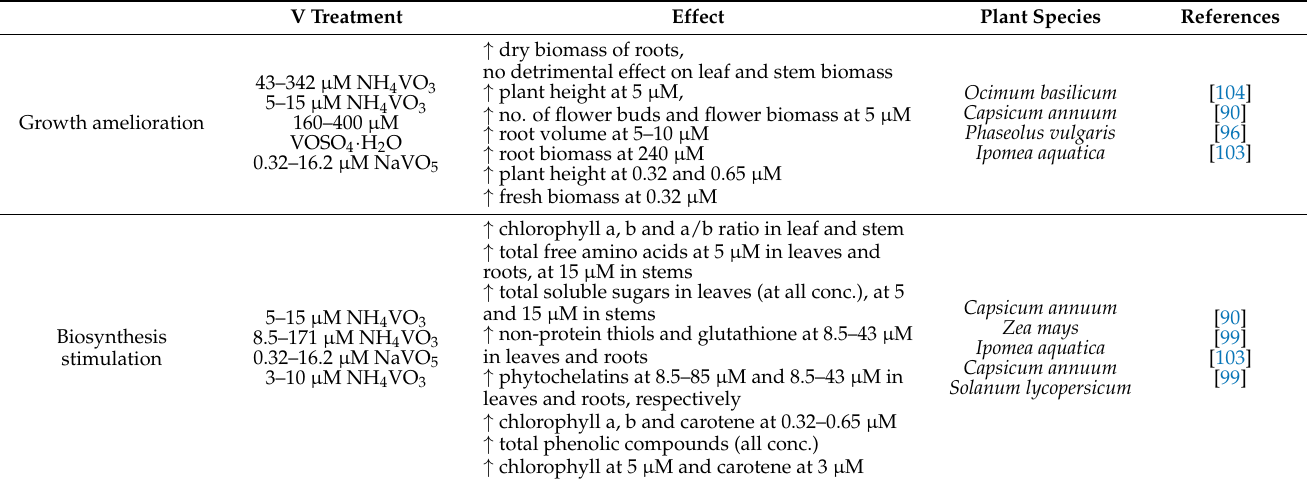
Table 2. Examples of beneficial effects of vanadium on plant